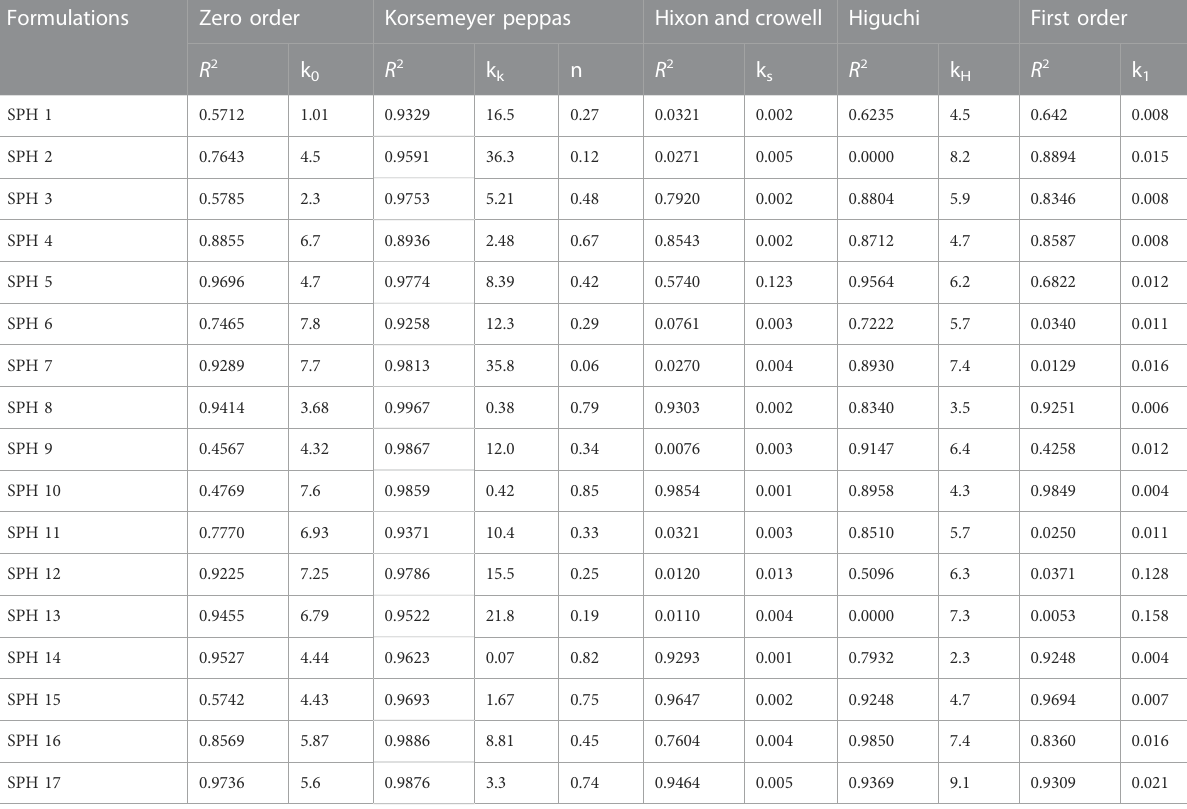
TABLE 7 Model dependent approach of superporous hydrogel formulations in 0.1NHCL (pH 1.2).